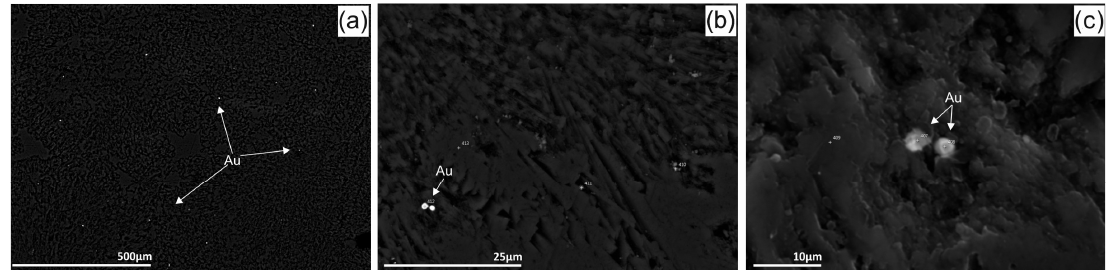
Figure 13. BSE photographs. ( a–c ) Abundant native gold in the interspace and on the surface of aragonite crystals.